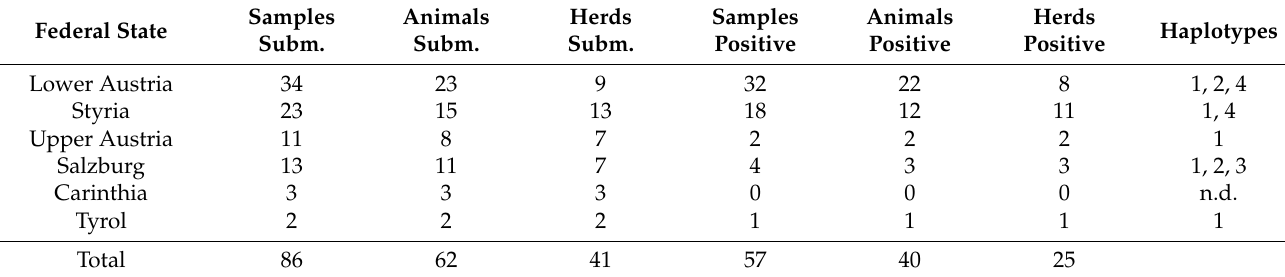
Table 2. Overview of the number of samples, affected cattle, herds, and haplotypes detected.